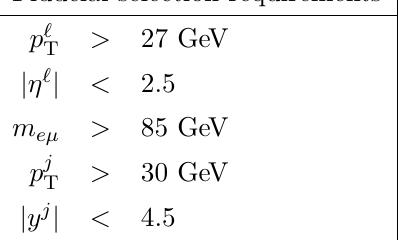
Table 5 . Definition of the WW → eµ +jets fiducial phase space, where p ‘ transverse momentum (pseudorapidity) of charged leptons and p j (rapidity) of